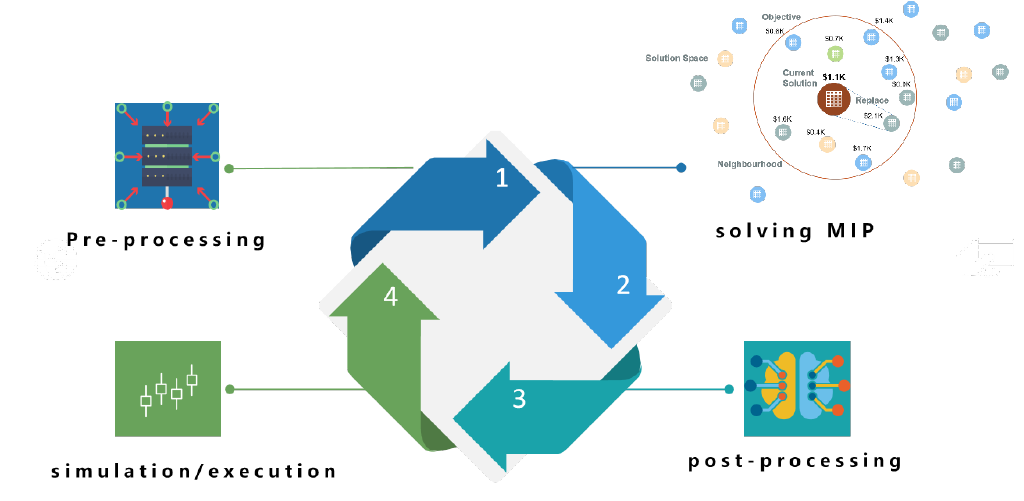
Figure 2. Solution framework.